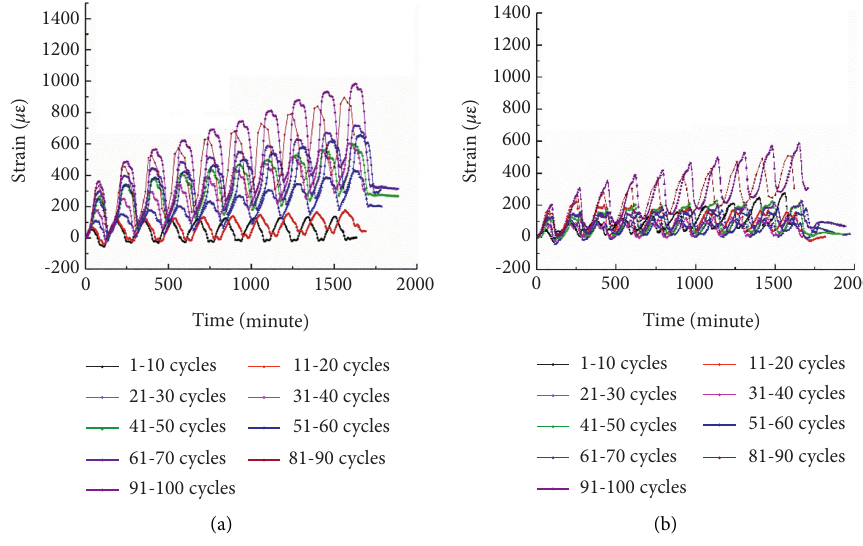
Figure 9: Strains from the start to the end during every 10 F-T cycles. (a) W/C � 0.55. (b) W/C �